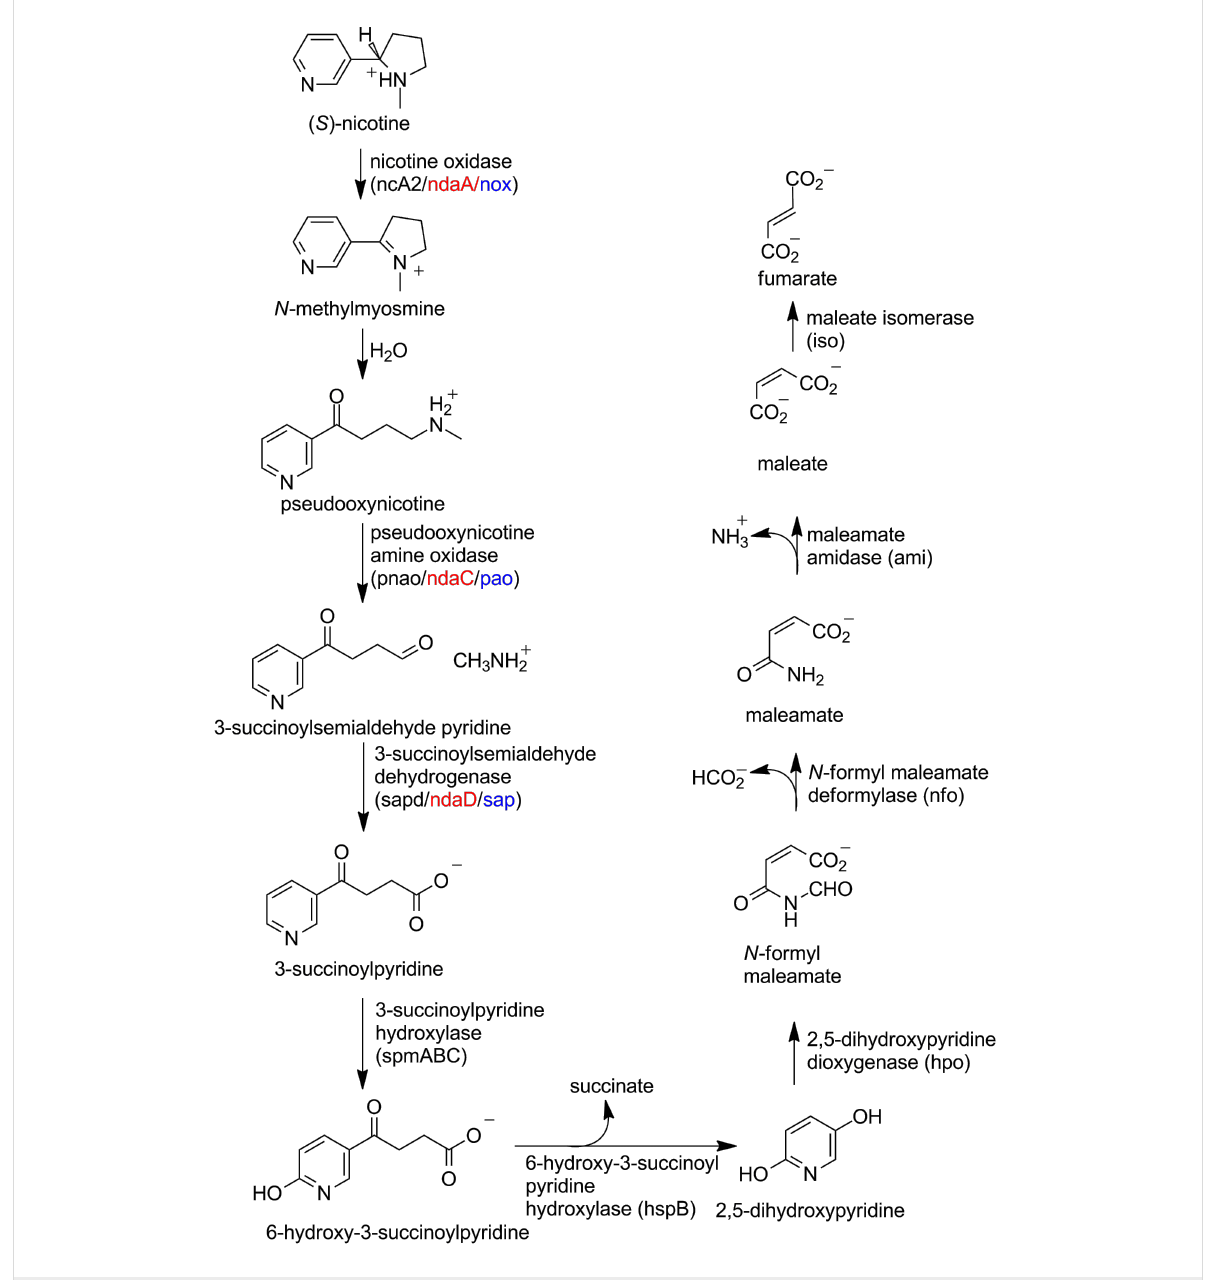
Scheme 8: The pyrrolidine pathway for nicotine degradation by pseudomonads. The gene names for P. putida S16 (black), P. putida J5 (red), and Pseudomonas sp. HZN6 (blue) are in parentheses.